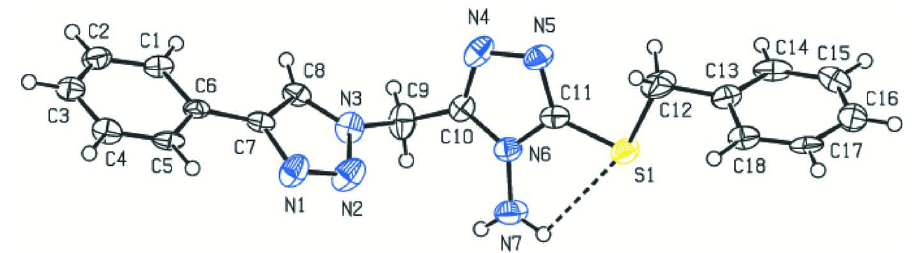
Figure 1 The structure of the compound (I) showing 50% probability displacement ellipsoids and the atom numbering